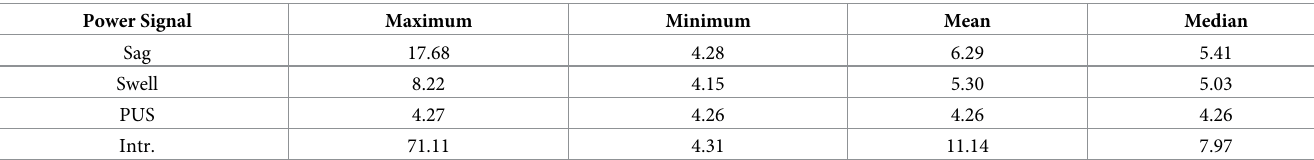
Table 1. Summary of the samples ratios. Power Signal Maximum